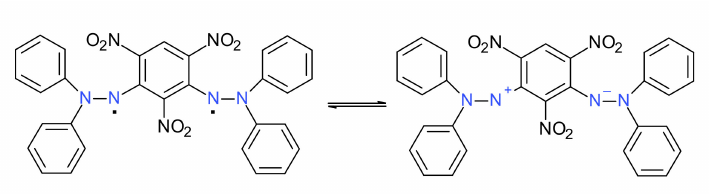
Figure 13. A dihydrazyl and its zwitterionic form.